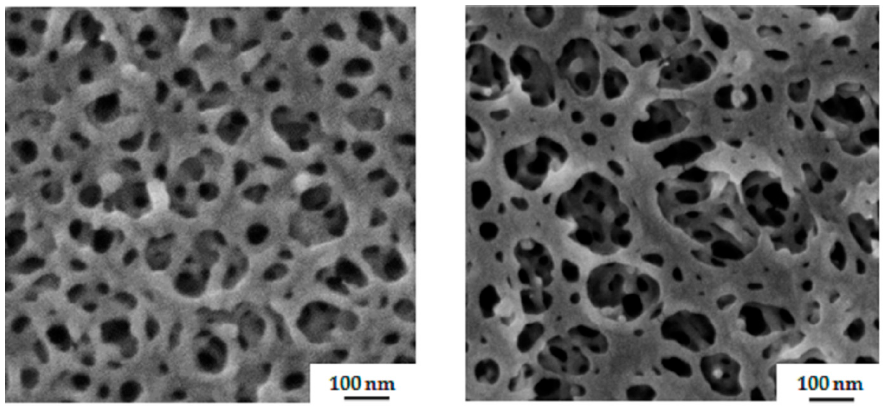
Figure 6. SEM topography images of the surface of the generated membrane from 25 wt % PS 76 -PSMA 24200 in THF/DMF 30/70 wt % with evaporation time 10 s ( left ) and 20 s ( right ).